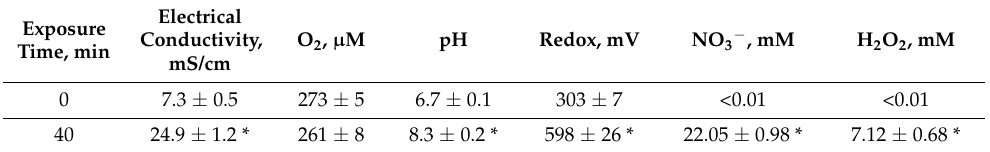
Table 2. Physicochemical properties of PTS after treatment with high-frequency glow discharge of an aqueous solution of NaCl 0.1M. Exposure Time,